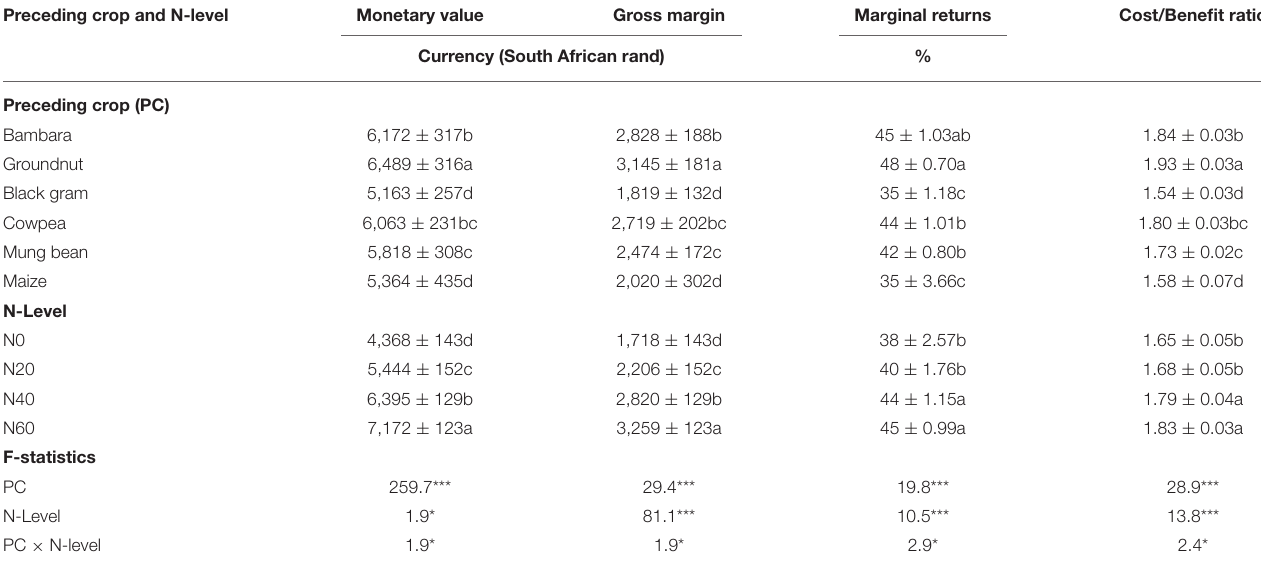
TABLE 5 | Two-Way ANOVA of the effect of the preceding crop on economic parameters of maize planted in rotation with four N-levels at Nelspruit in the Mpumalanga Province during the 2012/2013 cropping season. Preceding crop and N-level Monetary value Gross margin Marginal returns Cost/Benefit ratio Currency (South African rand)